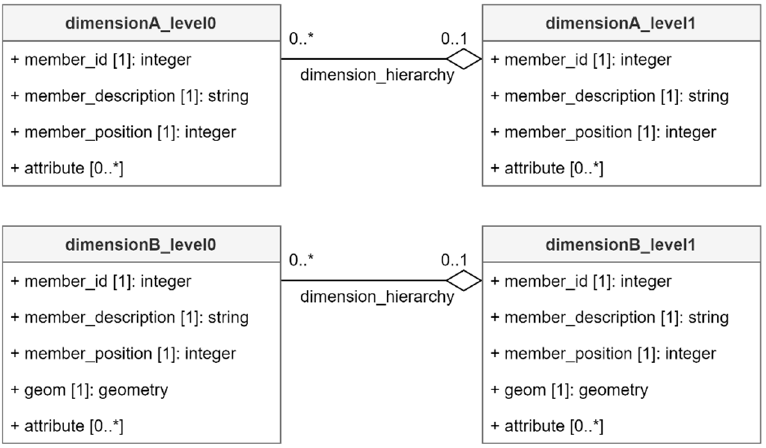
Figure 11. Instantiated dimensions. Asterisk means “n” according to UML convention.